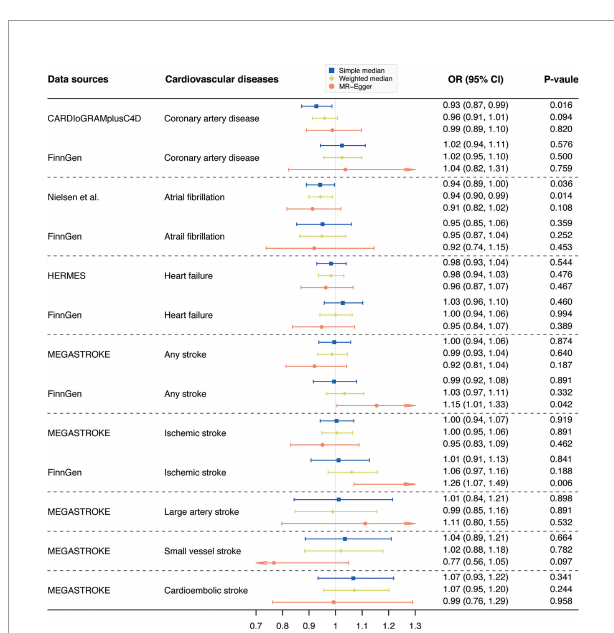
FIGURE 3 | Complementary analyses of the association between circulating a -Klotho levels and cardiovascular diseases. OR, odds ratio; CI, con fi dence interval; CARDIoGRAMplusC4D, Coronary ARtery DIsease Genome-wide Replication and Meta-analysis (CARDIoGRAM) plus The Coronary Artery Disease (C4D) Genetics; HERMES, Heart Failure Molecular Epidemiology for Therapeutic Targets. Note: as no outlier was identi fi ed by Mendelian randomization-pleiotropy residual sum and outlier (MR-PRESSO), results from MR-PRESSO were not shown in this fi